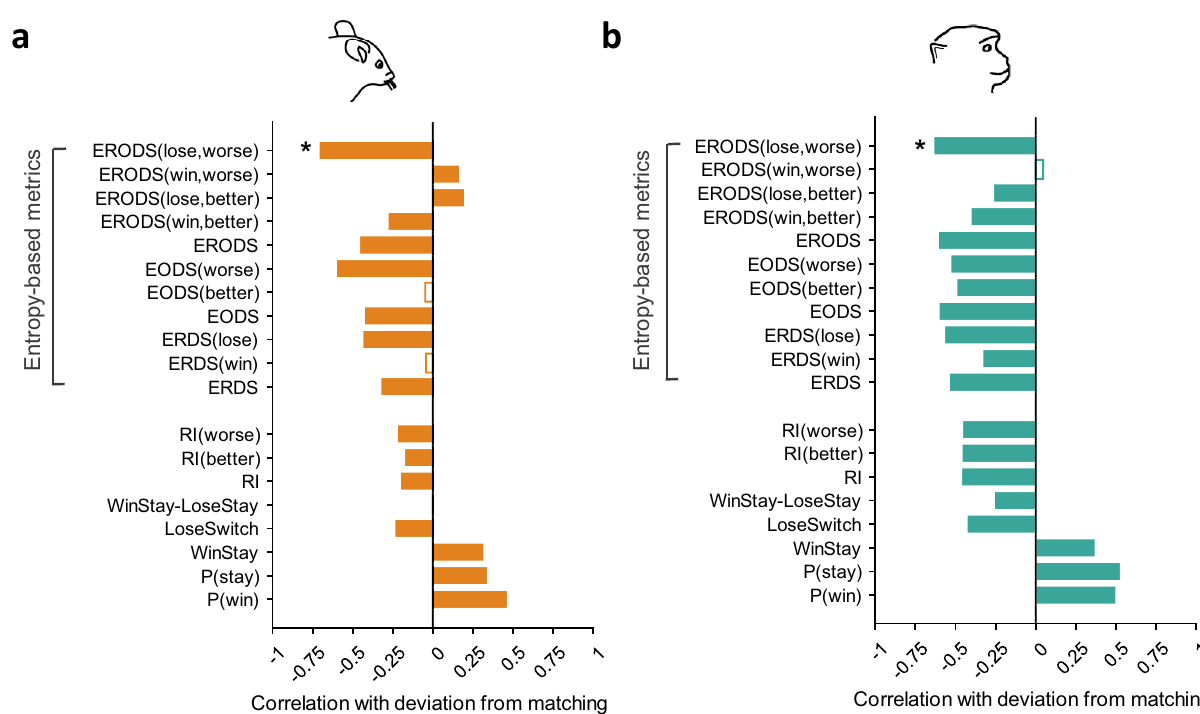
Fig. 4 Correlation between undermatching and proposed entropy-based metrics and underlying probabilities. a Pearson correlation between proposed entropy-based metrics and existing behavioral metrics and deviation from matching in mice. Correlation coef fi cients are computed across all blocks, and metrics with nonsigni fi cant correlations (two-sided, p > 0 : 0001 to account for multiple comparisons) are indicated with a hollow bar. The metric with the highest correlation with deviation from matching is indicated with a star (ERODS W − ; r ¼ (cid:2) 0 : 71 ; p < 10 (cid:2) 300 ). b Similar to ( a ) but for monkeys (ERODS W − ; r ¼ (cid:2) 0 : 64 ; p ¼ 10 (cid:2) 231 ). Overall, entropy-based metrics show stronger correlation with deviation from matching than existing